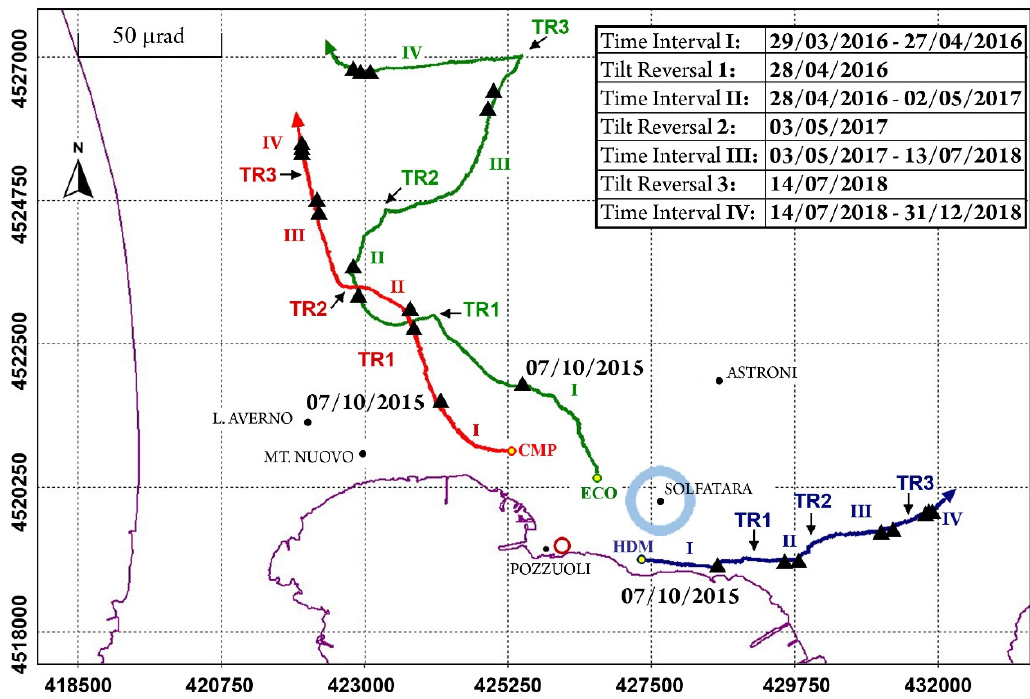
Figure 3. Schematic map of Campi Flegrei, superimposed on a grid representing the two-dimensional plane of ground inclinations, in which each mesh is equivalent to a tilt variation of 50 µ radians. The three sites CMP, ECO and HDM are distinguished by di ff erent colors (red, green and blue, respectively), as well as the curves that originate from them: the latter indicates the cumulative tilt variation (hodograph) recorded since 29 March 2015 to 31 December 2018. The roman numerals indicate four time subintervals separated by the occurrence of a tilt reversal episode (TR) and characterized by di ff erent kinematics. On the same grid the earthquakes with Md > 1.6 are shown with black triangles and the area of maximum uplift is shown with a red circle. The light blue circle encompasses the area where VT seismicity occurred.